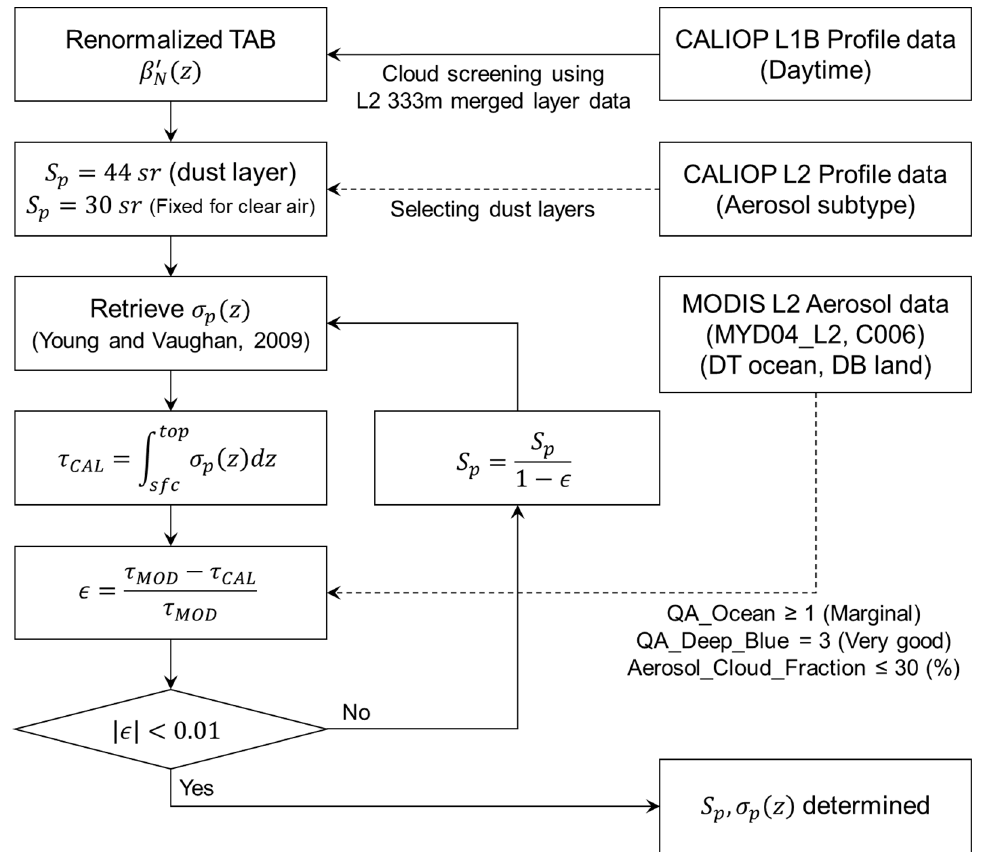
Figure 1. A flowchart for the aerosol extinction retrieval for dust layers using Moderate Resolution Imaging Spectroradiometer (MODIS) Aerosol Optical Depths (AOD) as a constraint, modified from Figure 1 of Kim et al.